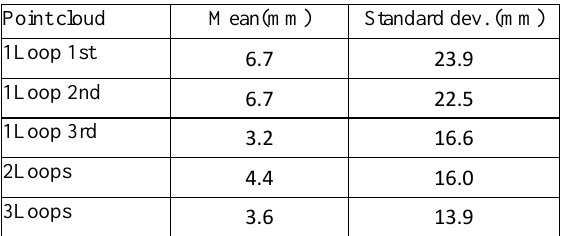
Table 2: Cloud to cloud error analysis of point